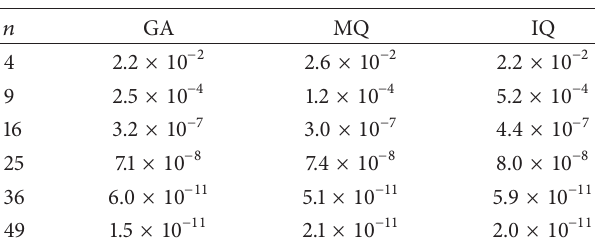
Table 2: Numerical results of different RBFs for Example 2. The roots of Legendre polynomial are chosen as center points.